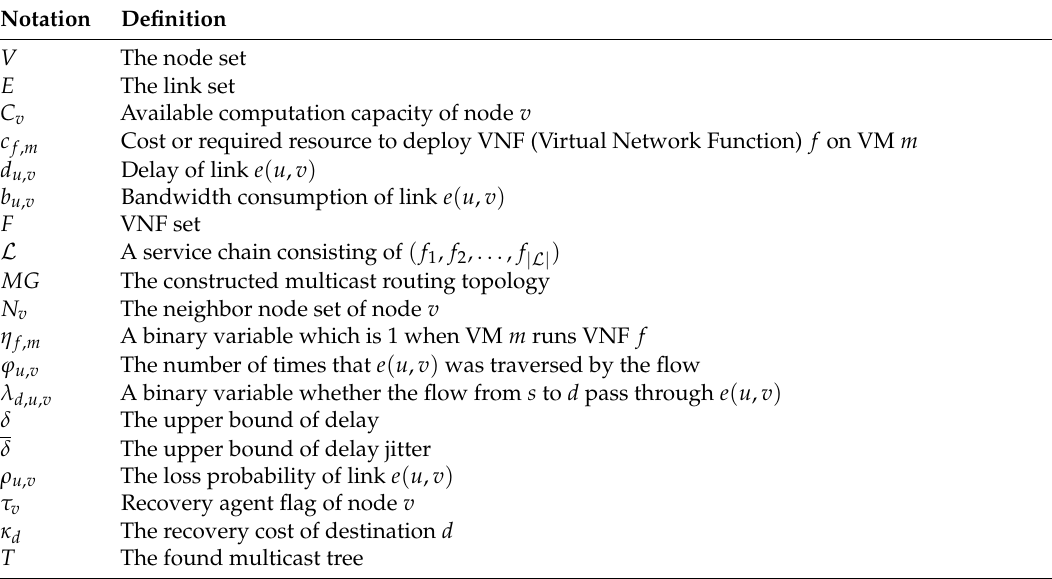
Table 1. List of